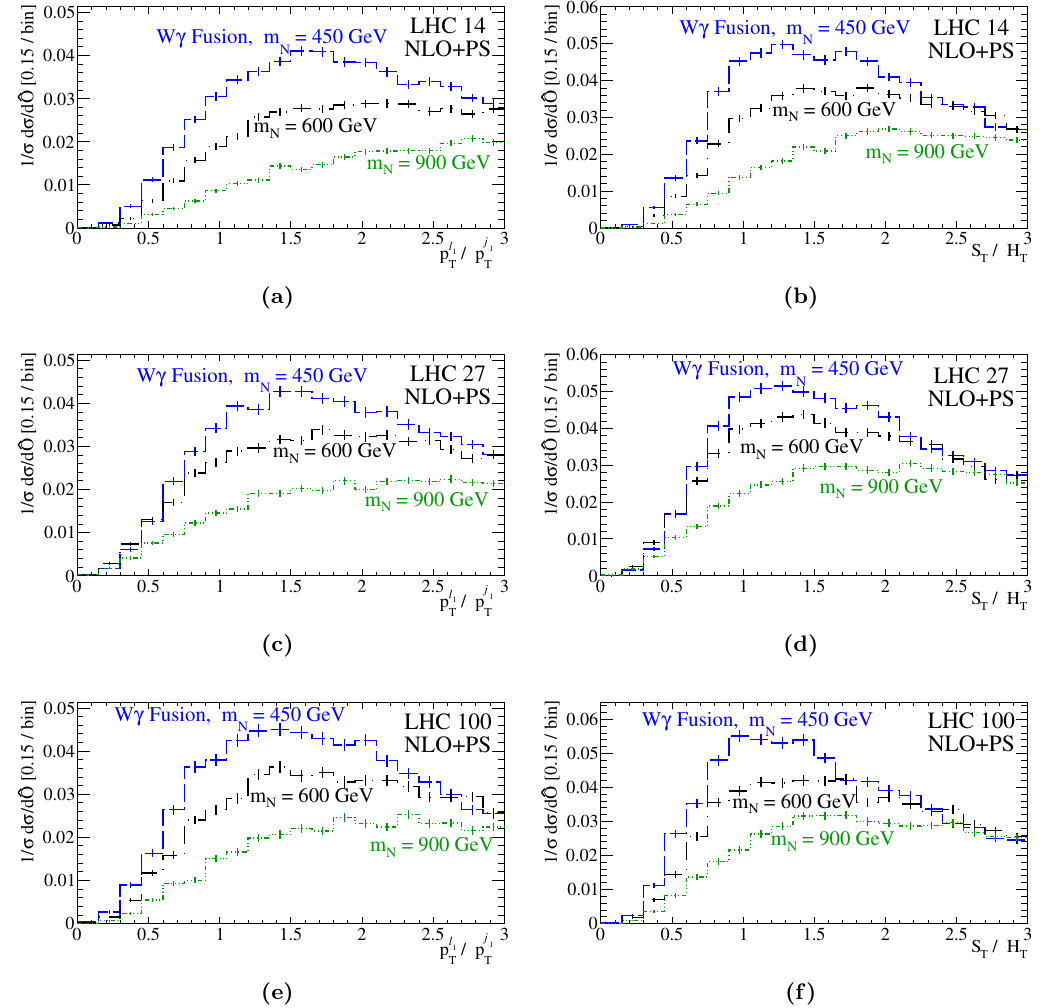
Figure 19. Normalized NLO+PS distributions with respect to the ratios (a,c,e) p ‘ 1 S T =H T , at (a,b) p s = 14 TeV, (c,d) 27 TeV, and (e,f) 100 TeV, for the W(cid:13) fusion (VBF) signal process, with m N = 450 GeV (dash), 600 GeV (dash-dot), and 900 GeV (dash-3